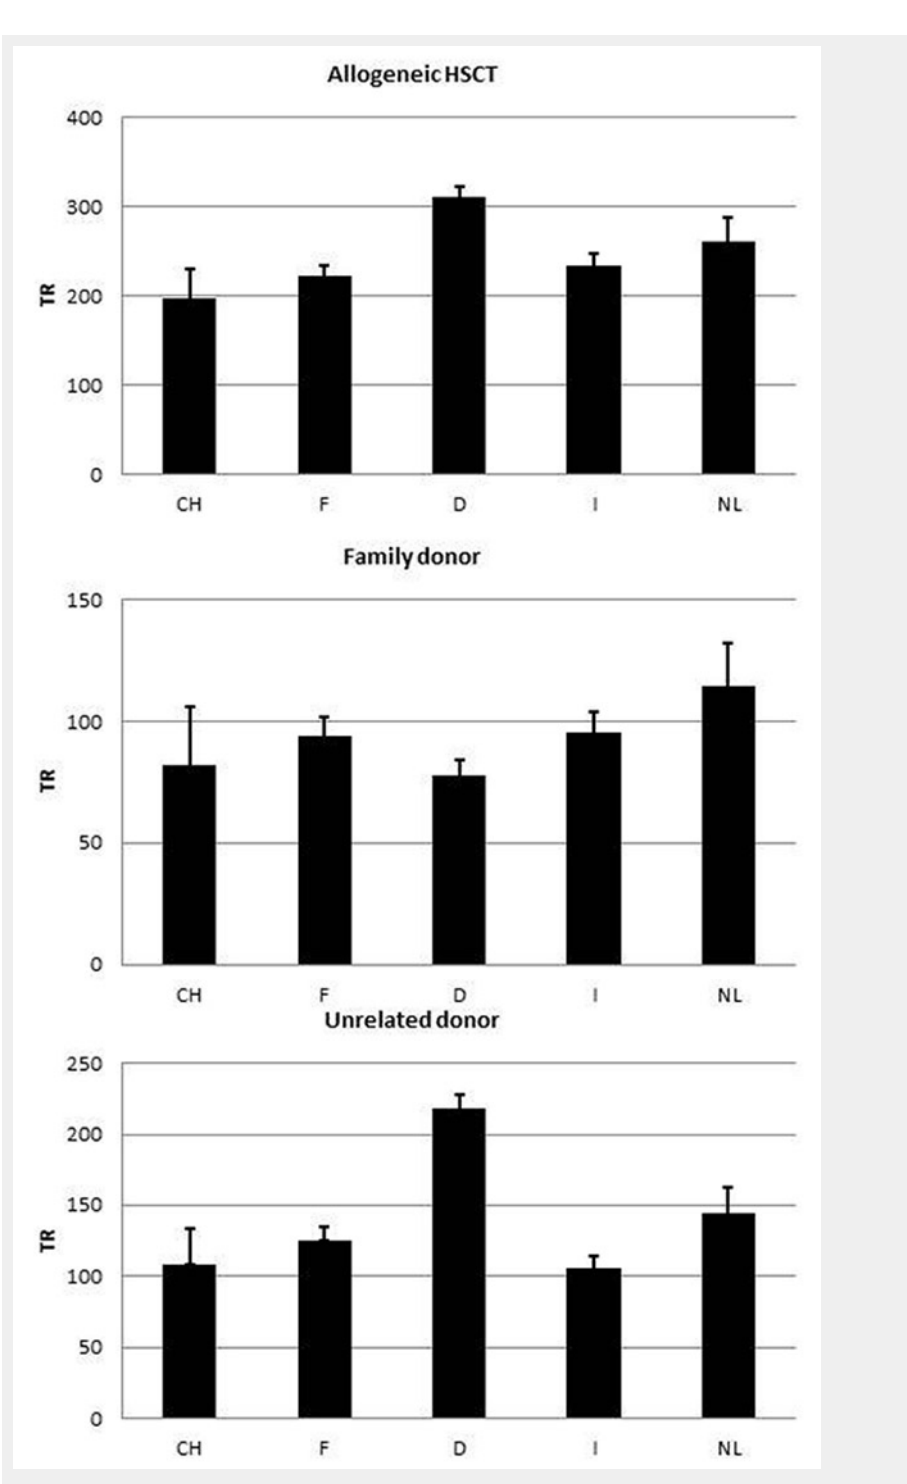
Figure 1 Allogeneic HSCT rates per 10 million inhabitants per year. 1a: all allogeneic HSCT. 1b: allogeneic HSCT from a family donor. 1c: allogeneic HSCT from an unrelated donor (CH: Switzerland, F: France, D: Germany, I: Italy, NL: the